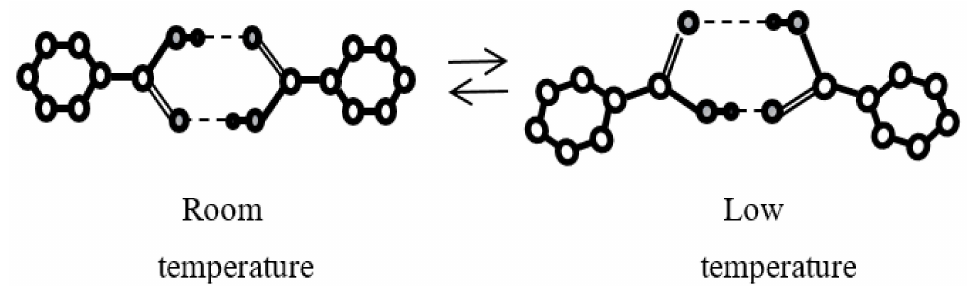
Figure 12. Dimers of benzoic acid in a crystal at room and low